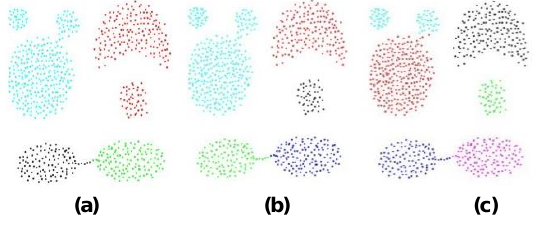
Figure 8. HUALM algorithm can thoroughly cluster the aggregation dataset after three levels, a) level-1, b) level-2, c)